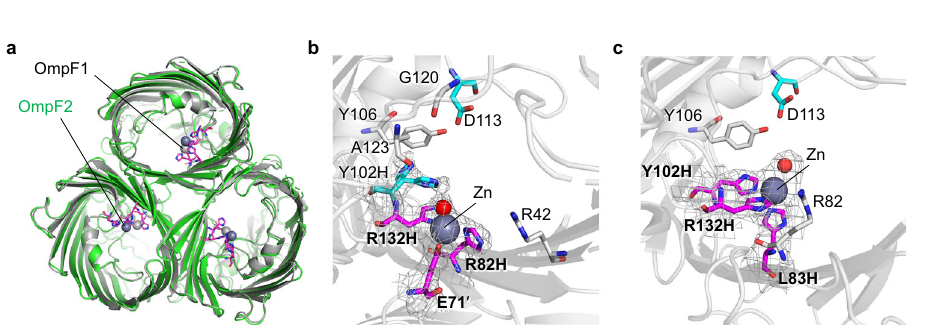
and iteratively optimized residues are shown with cyan and gray sticks, respec- tively. The gray grid represents 2F o − F c electron density of the Zn-ligating site contoured at 1.0 σ